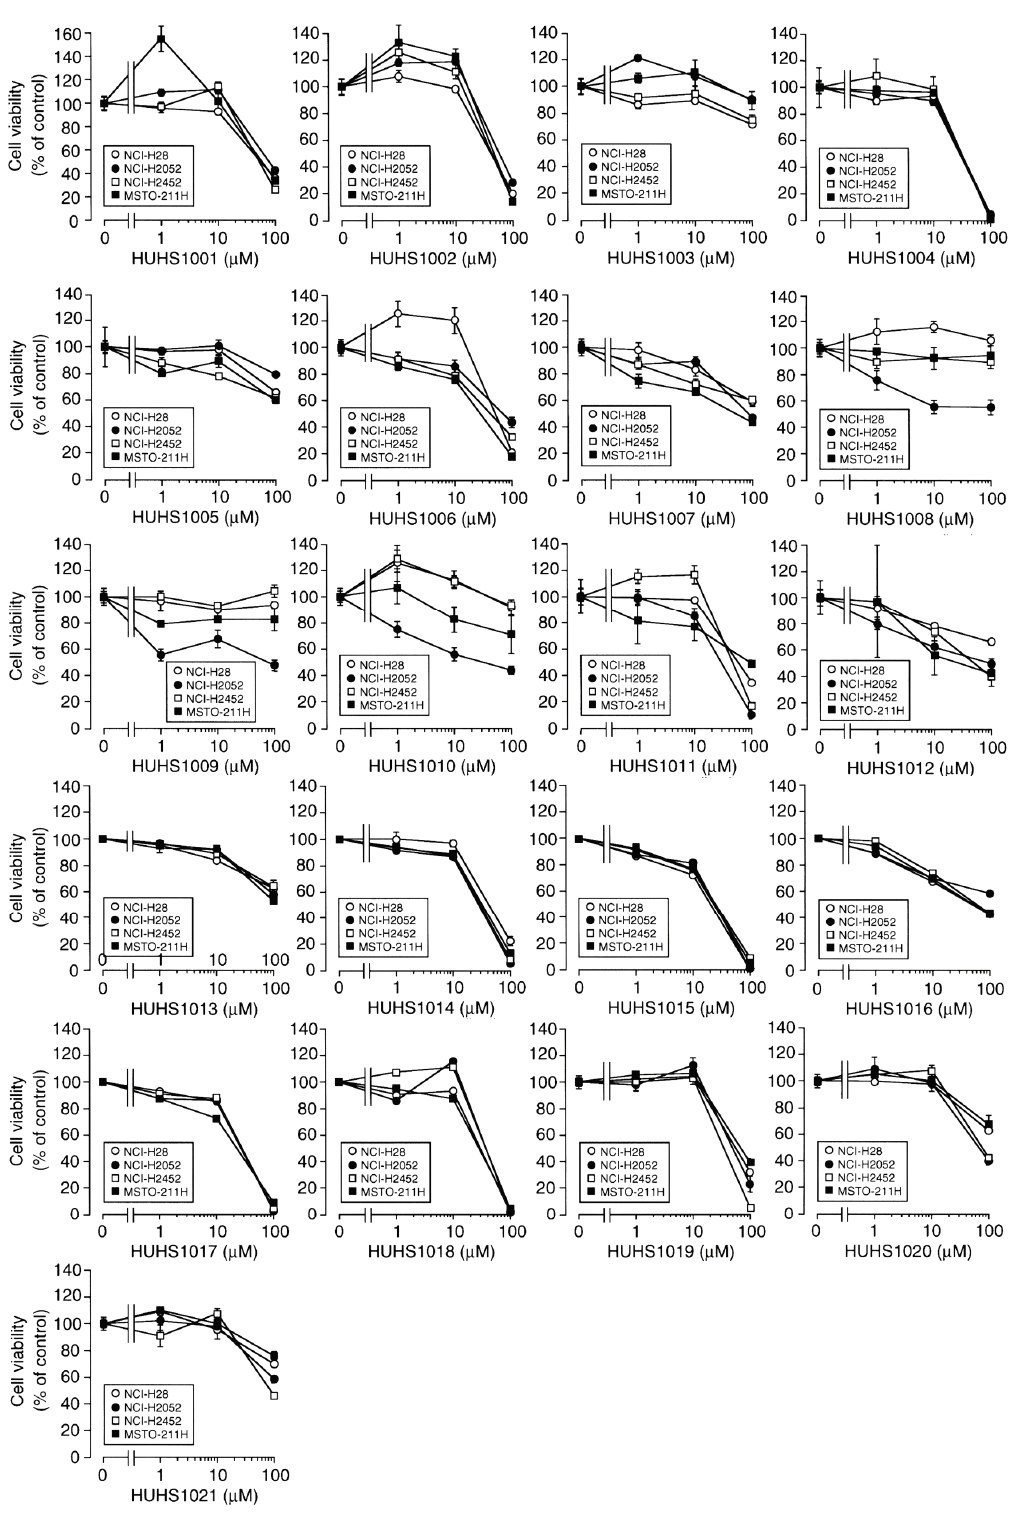
Figure 2. The effect of naftopidil analogues on cell viability for malignant mesothelioma cell lines. MTT assay was carried out in NCI-H28, NCI-H2052, NCI-H2452, and MSTO-211H cells untreated and treated with naftopidil analogues at concentrations as indicated for 24 h. In the graphs, each point represents the mean (± SEM) percentage of control (MTT intensities for cells untreated with naftopidil analogues) ( n = 4 independent